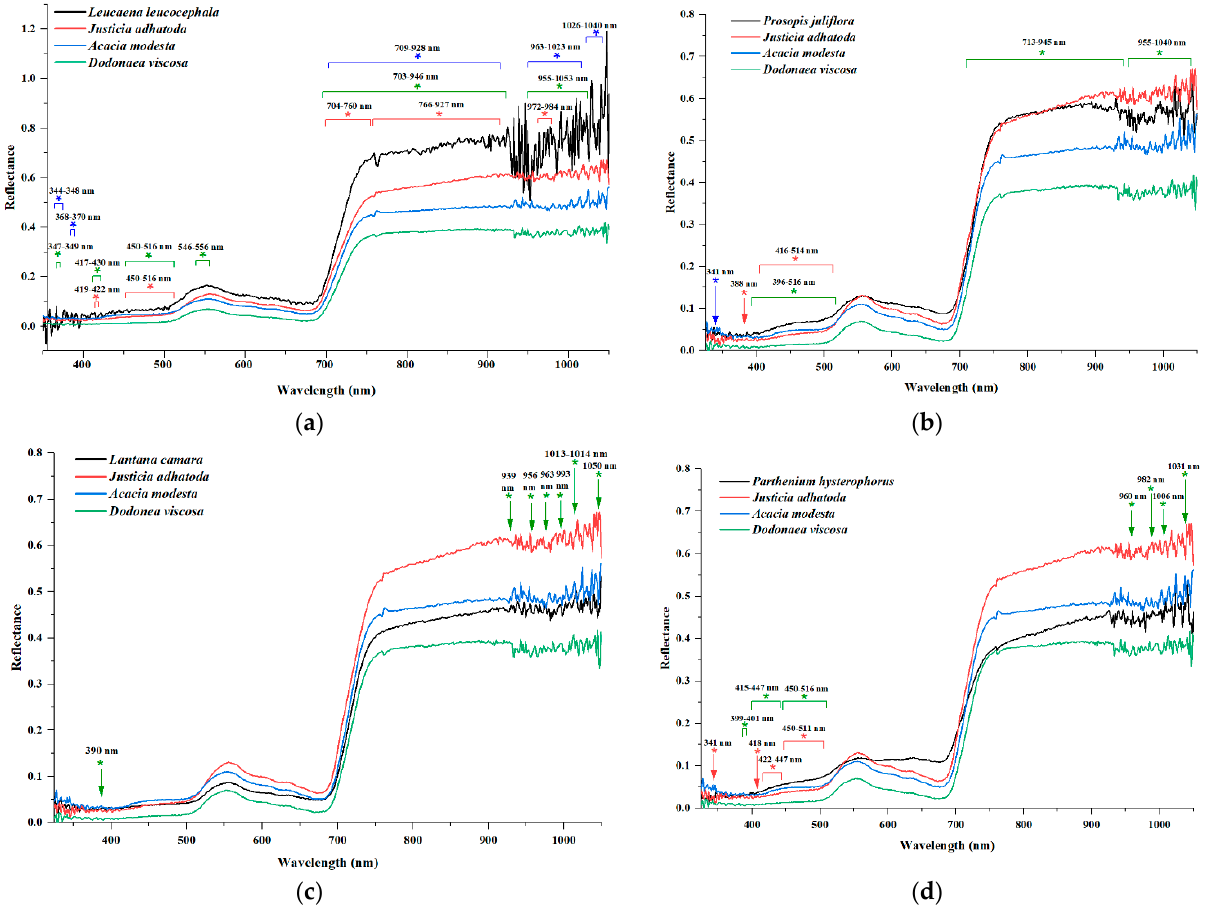
Figure 10. Graphical representation of pairwise comparisons of plant species. Each graph shows comparative analysis of native vs. invasive species spectra. Bars and arrow represent the significant discriminating wavebands with one of the invasive species, L. leucocephala ( a ) P. juliflora ( b ) L. camara ( c ) and P. hysterophorus ( d ) in each graph.